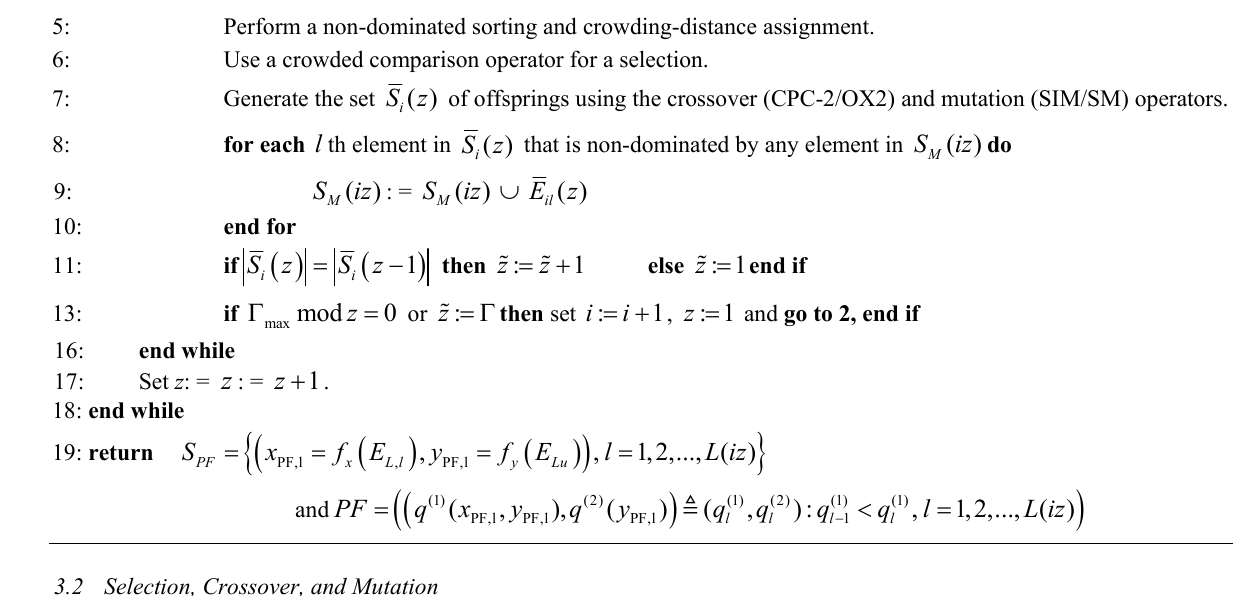
0.95   1986). For the binary parts, the Count-Preserving Crossover c